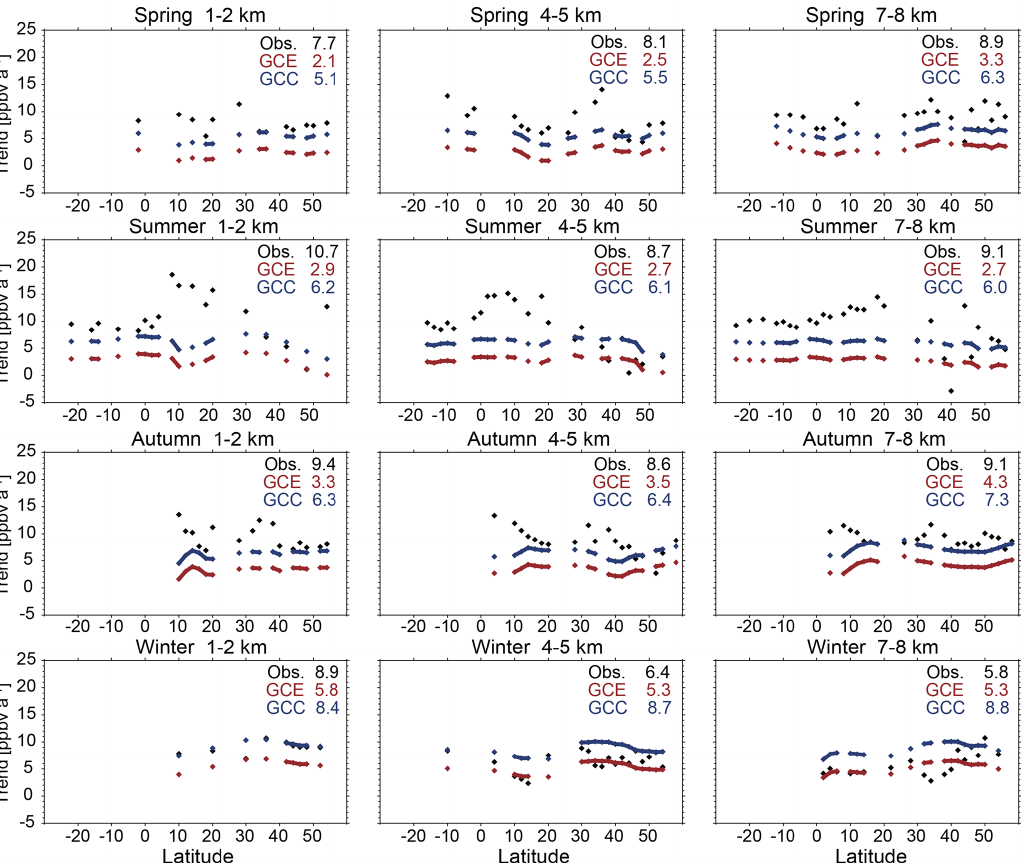
Figure 10. Comparisons of simulated CH 4 trends in GCE (with EDGAR anthropogenic emissions and interannually varying OH; red dots) and GCC (with CEDS and interannually varying OH; blue dots) against aircraft observation trends (black symbols) in four seasons (spring: sults sampled along the flight tracks are averaged in 2 ◦ latitude bins and at three altitude levels (left: 1–2km; middle: 4–5km; and right: 7–8km). Mean observed and simulated CH 4 trends are shown inset. Table 4. Contributions of region- and sector-specific emissions to the surface CH 4 trends in China over 2007–2018 ∗